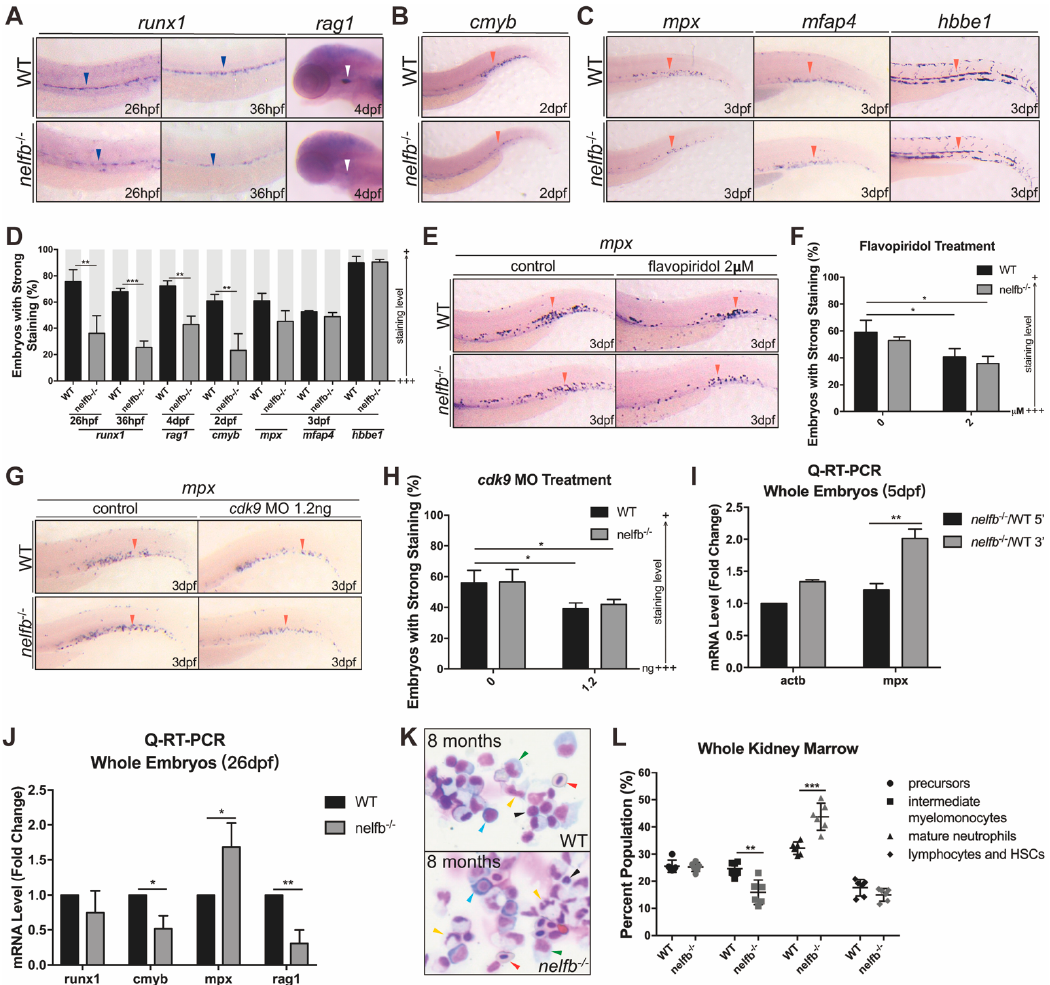
Figure 6. Granulocytic differentiation at late developmental stages and in adulthood also shows defects in nelfb - /- zebrafish. ( A ) WISH for runx1 or rag1 in WT and nelfb -/- embryos at 26 hpf and 4 dpf. ( B ) WISH for cmyb in WT and nelfb -/- embryos at 2 dpf. ( C ) WISH for mpx , mfap4 , and hbbe1 in WT and nelfb -/- embryos at 3 dpf. Blue arrowheads, white arrowheads, and red arrowheads, respectively, indicate AGM region, thymus, and CHT. ( D ) Quantification of WISH results in (A-C) ( n = 30–40 embryos per group). ( E ) WISH for mpx at 3 dpf in WT and nelfb -/- embryos treated with flavopiridol. ( F ) Quantification of WISH results in E ( n = 20–30 embryos per group). ( G ) WISH for mpx at 3 dpf in WT and nelfb -/- embryos injected with 1.2 ng cdk9 MO. ( H ) Quantification of WISH results in H ( n = 20–30 embryos per group). ( I ) Q-RT-PCR analysis of 5 ′ and 3 ′ transcripts of mpx gene in WT and nelfb -/- embryos at 5 dpf. Gene expression is normalized to the 5 ′ transcript of β -actin and shown as fold-change relative to WT. ( J ) Q-RT-PCR analysis of hematopoiesis-related genes in WT and nelfb -/- mutant fish at 26 dpf. Gene expression is normalized to β -actin and presented as fold- change relative to WT. ( K ) May–Grünwald–Giemsa staining of WKM from WT and nelfb -/- fish at 8 mpf. Blue arrowheads, precursors; green arrowheads, intermediate myelomonocytes; yellow arrowheads, mature neutrophils; black arrowheads, lymphocytes and HSCs; red arrowheads, erythrocytes. ( L ) Quantification of WKM staining results. All results are presented as the mean ± SD from a representative of three independent experiments ( t test, * for p < 0.05, ** for p < 0.01, *** for p < 0.001). “+++” and “+” in ( D , F , H ) respectively represent strong staining and weak staining. Note: dpf, days post-fertilization; mpf, months post-fertilization; AGM region, aorta-gonad-mesonephros region; CHT, caudal hematopoietic tissue; WKM, whole kidney marrow; HSCs, hematopoietic stem